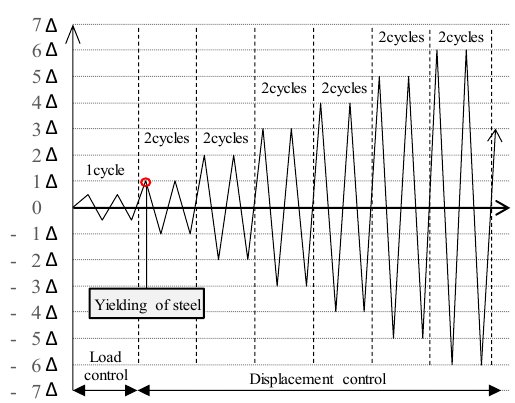
Figure 5. Loading